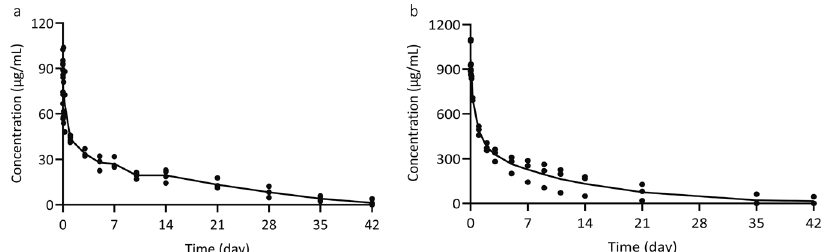
Fig. 4 Serum concentration vs. time pro fi les of CA521 FALA in mice and rhesus monkeys. a Four mice were administered intravenously at a dose of 10 mg/kg with CA521 FALA . Antibody concentrations in serum were determined in Elisa with SARS-CoV-2 (2019-nCoV) spike protein as the capture reagent. b Three healthy rhesus monkeys were administered intravenously at a dose of 50 mg/kg with CA521 FALA . The antibody concentration in serum at different time points were determined in Elisa with SARS-CoV-2 (2019-nCoV) spike protein as the capture reagent. The main PK kinetic parameters were calculated using Phoenix